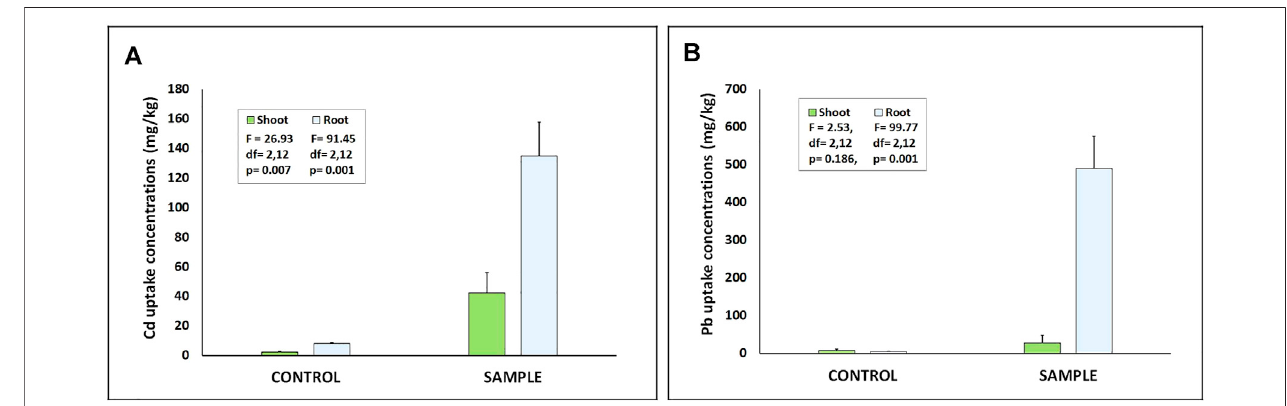
FIGURE 3 | Heavy metal uptake by roots and shoots of Cleome rutidosperma recorded in hydroponic experiments at 10 mg/kg tested concentration of (A) cadmium and (B) lead. There was a signi fi cant difference in the metal concentrations in the sample w.r.t control as well as the roots w.r.t to the shoots (F values and “ df ” are given in the respective graphs).